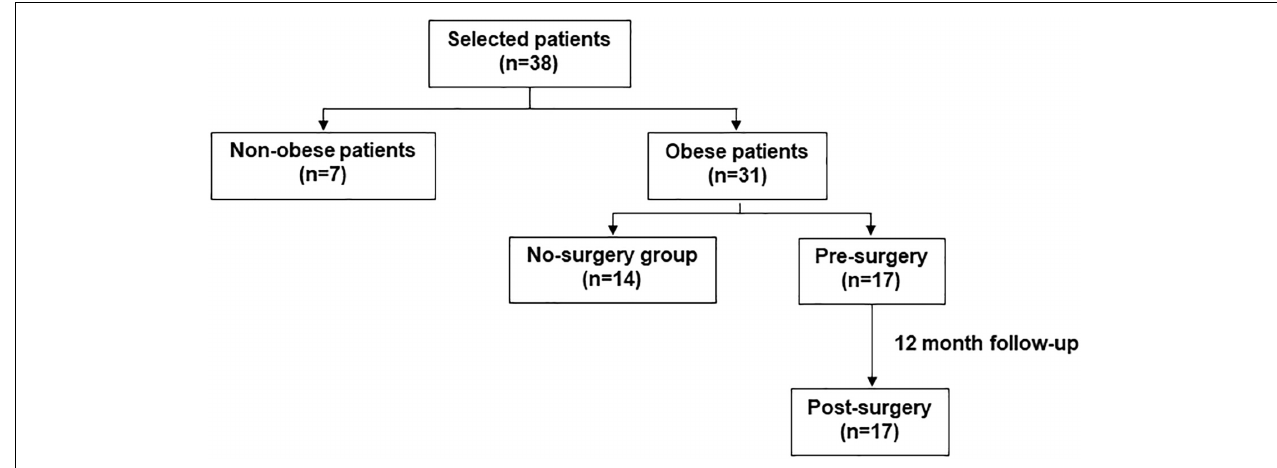
FIGURE 1 | Scheme explaining the study design and the patient selection